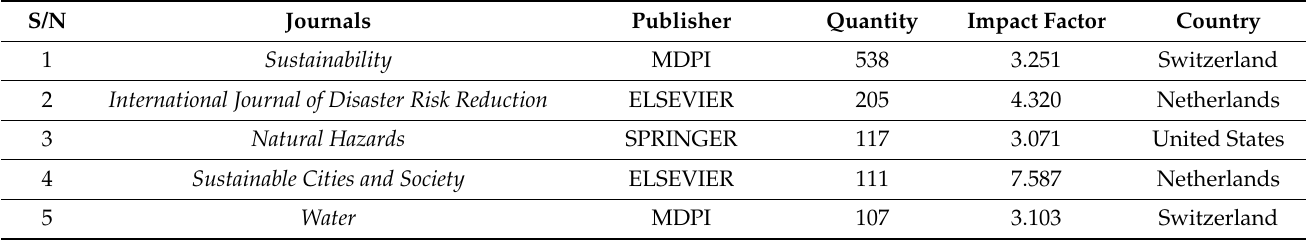
Table 1. Summary of the number of relevant literature works published in main